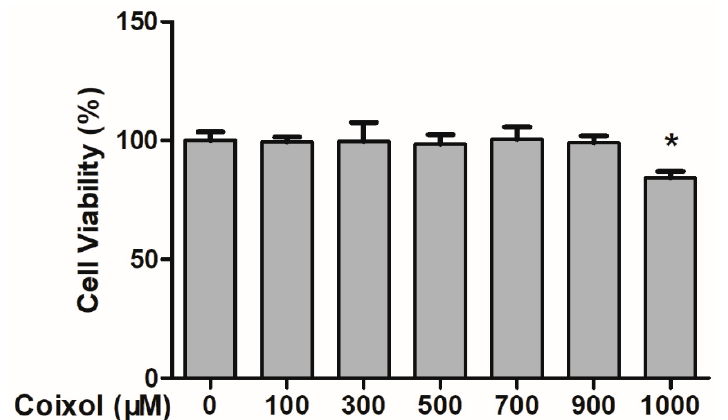
Figure 1. Effects of coixol on cell viability in RAW 264.7 cells. Cells were treated with various concentrations of coixol for 8 h. Cell viability was measured using a Cell Counting Kit-8. The data represent the mean ± SD ( n = 6). * p < 0.05 vs. control group.